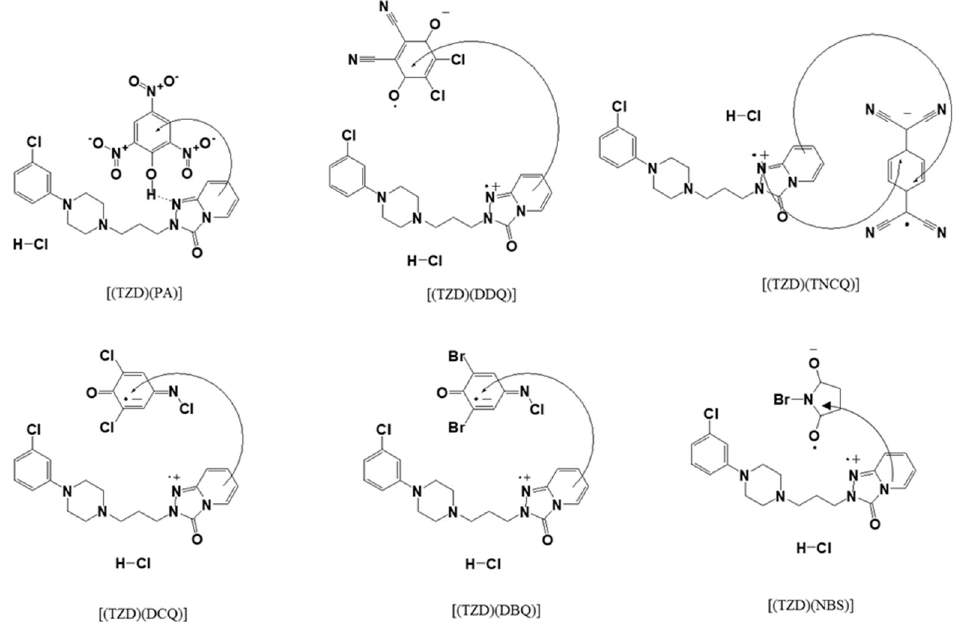
Figure 5. Speculated structures of the TZD-CT complexes.